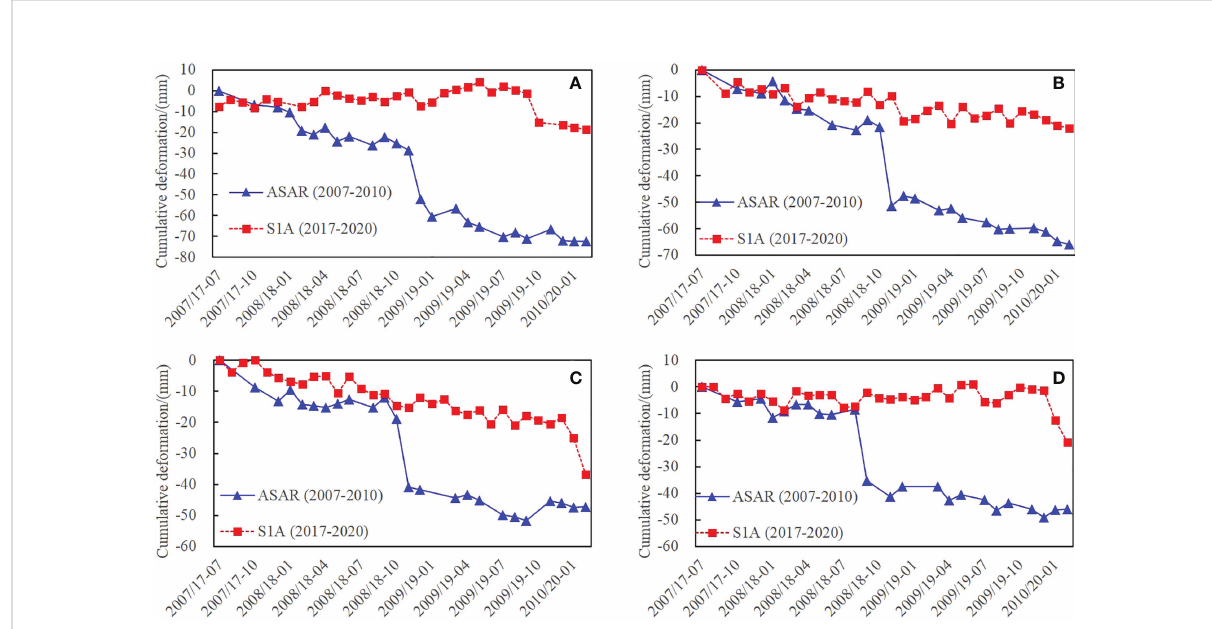
FIGURE 12 Time series of the surface subsidence at selected points CP_P1 (A) , CP_P2 (B) , CP_P3 (C) and CP_P4 (D) during the two periods of 2007-2010 and